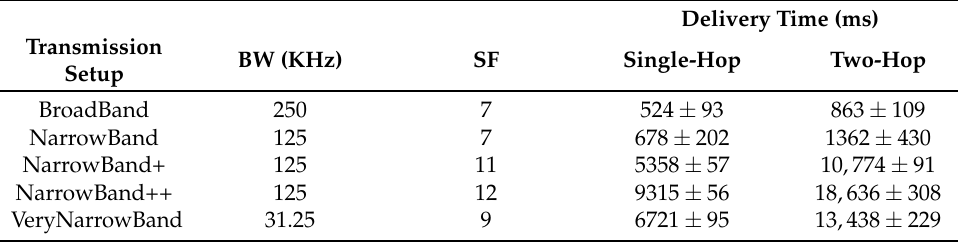
Table 1. Transmission setups and delivery time (with 95% confidence interval) for single-hop communi- cation between A and B (Figure 4) and two-hop communication between A and C (Figure